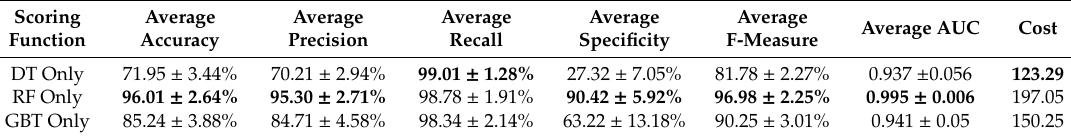
Table 9. Averaged evaluation results for individual scoring functions on seven classification models.